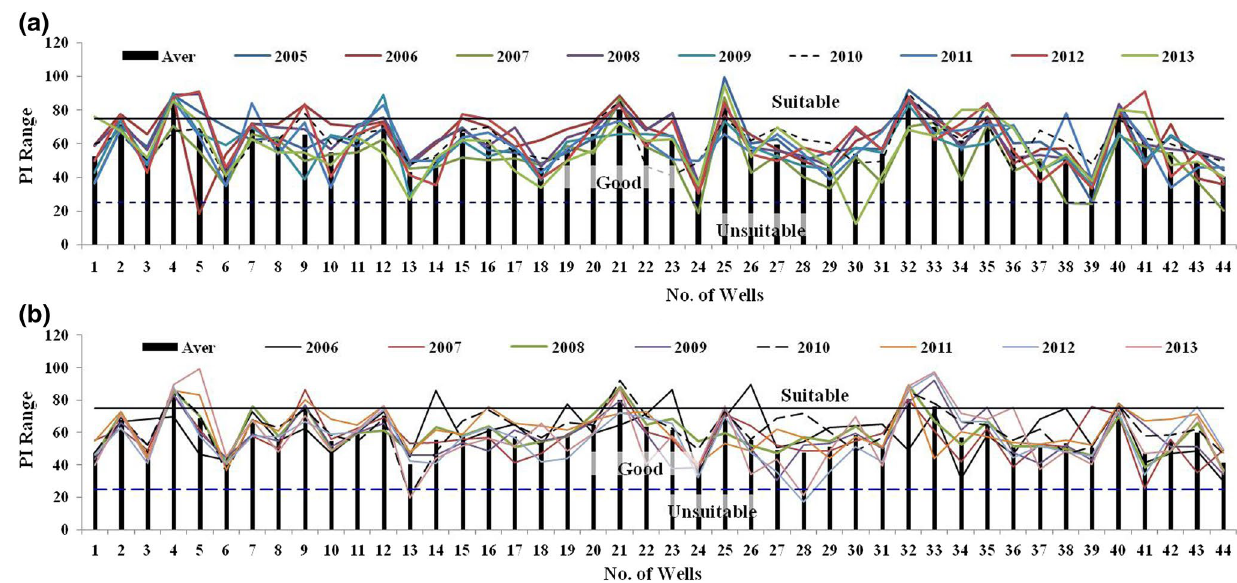
Fig. 6 a Nine-year (2005–2013) temporal representation of PI value during pre-monsoon. b Nine-year (2006–2013) temporal representation of PI value during post-monsoon